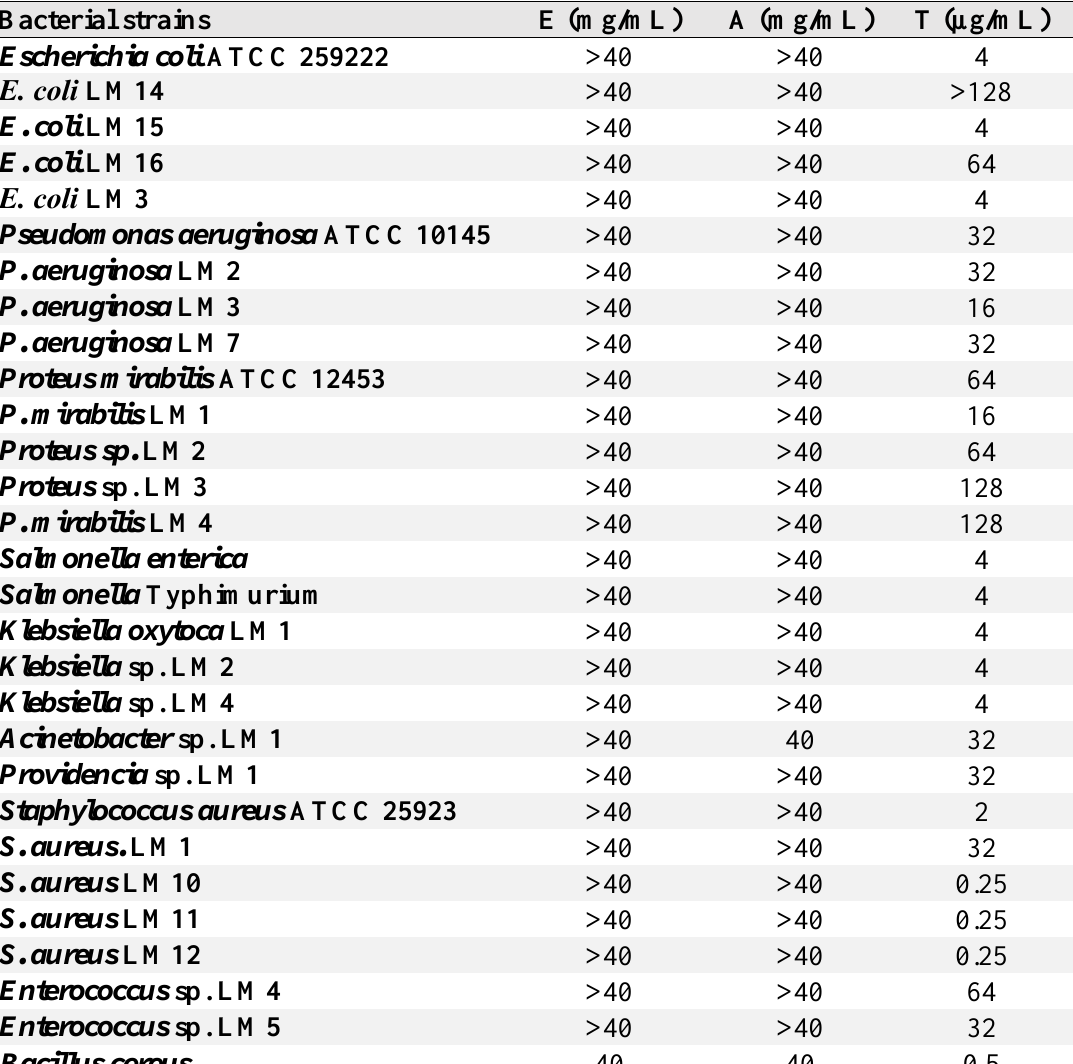
Table 7. Antibacterial activity (MIC values)